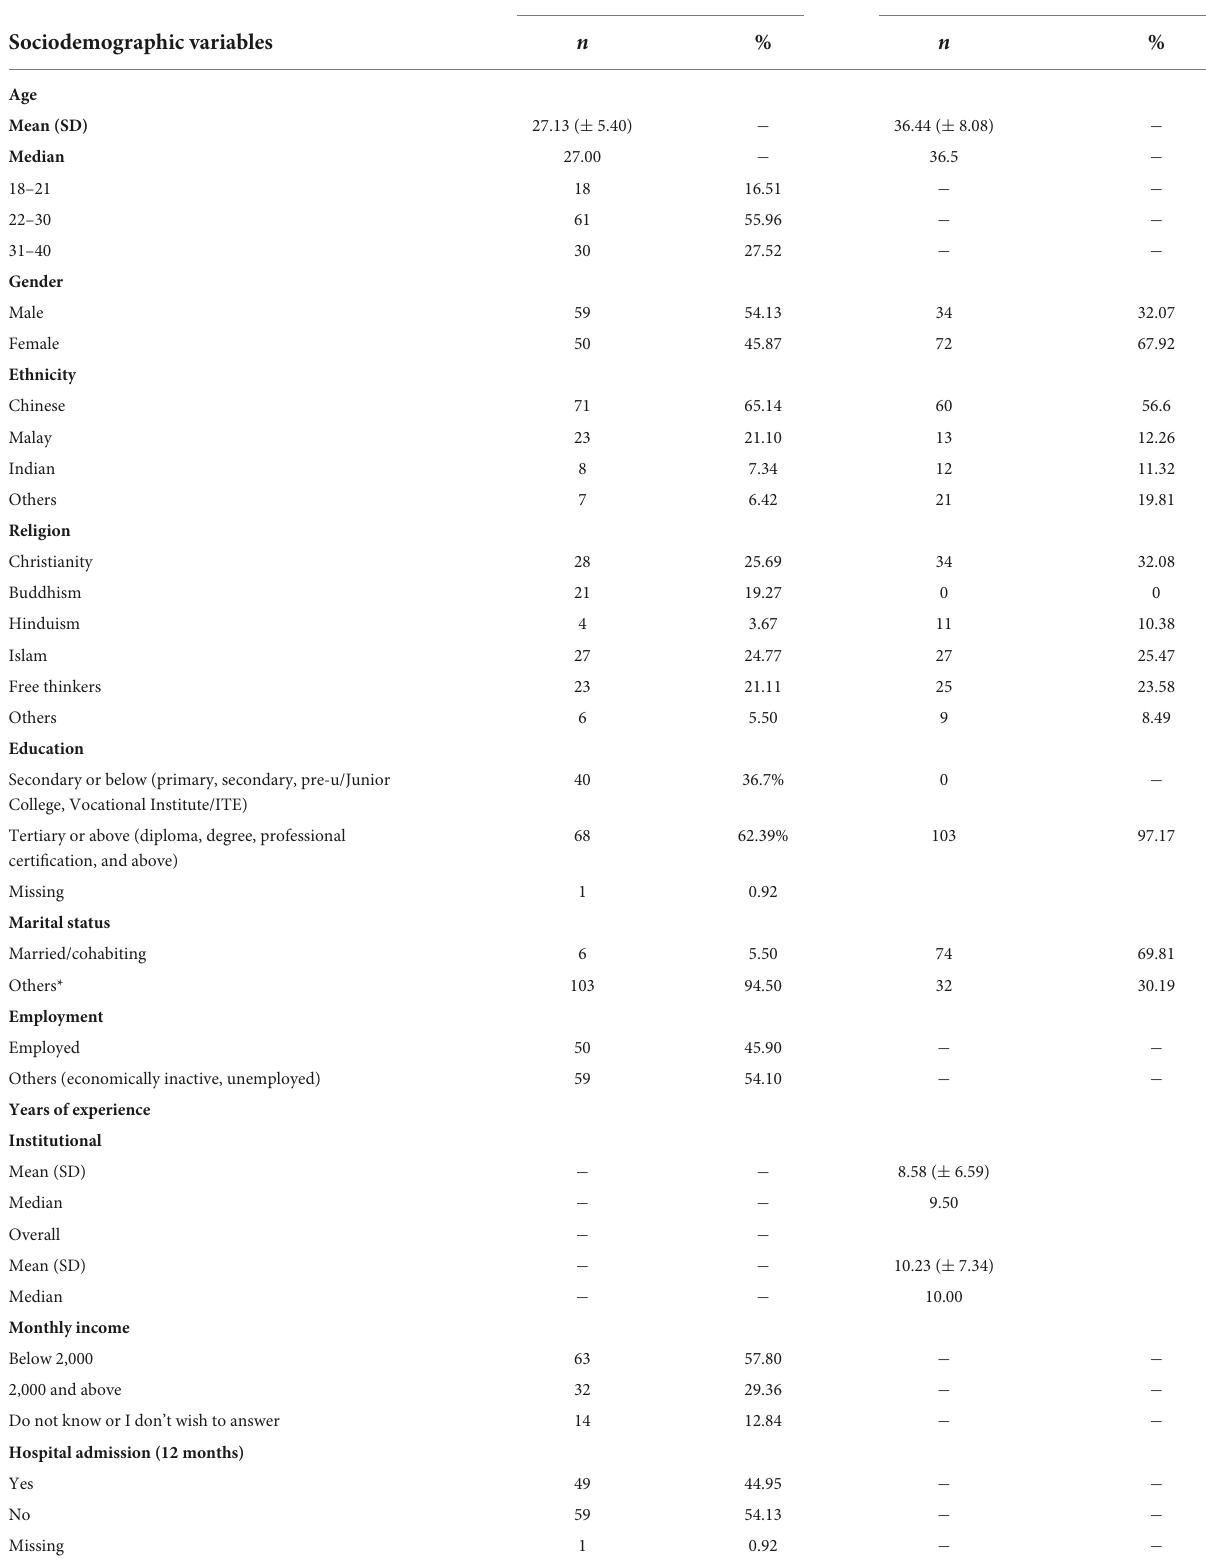
Patients ( n = 109) Care providers ( n =